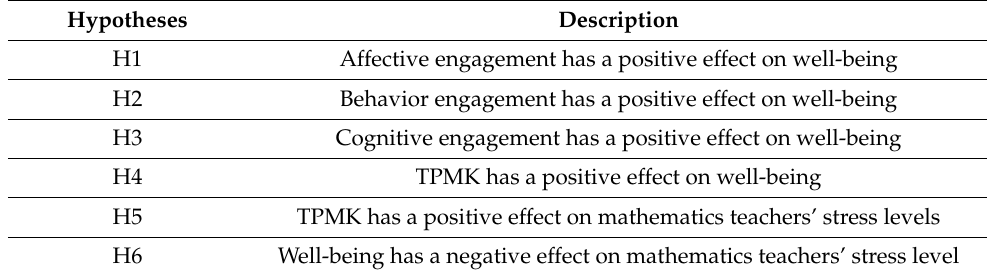
Table 1. The initial hypotheses of factors associated with well-being and mathematics teachers’ stress